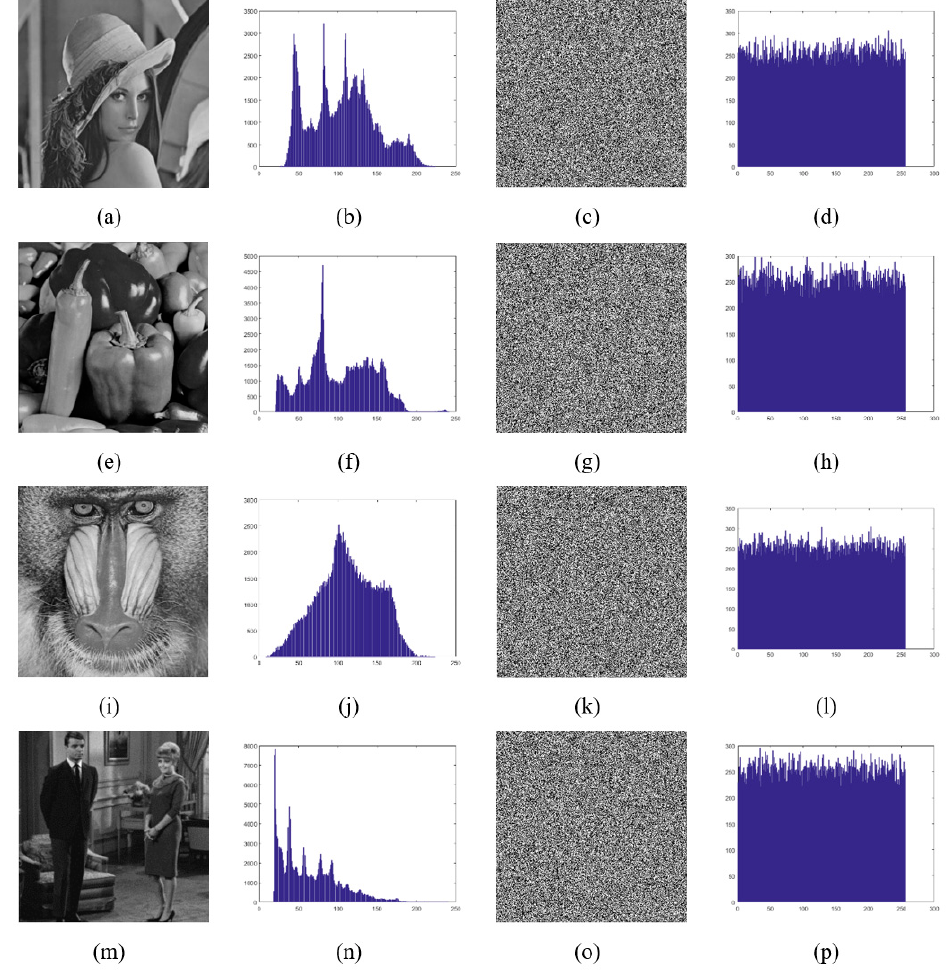
13 of 21 Figure 8. Key sensitivity analysis. ( a ) original image; ( b ) decrypted image using the correct decryption key; ( c ) decrypted image using incorrect decryption key. 4.4. Histogram Analysis